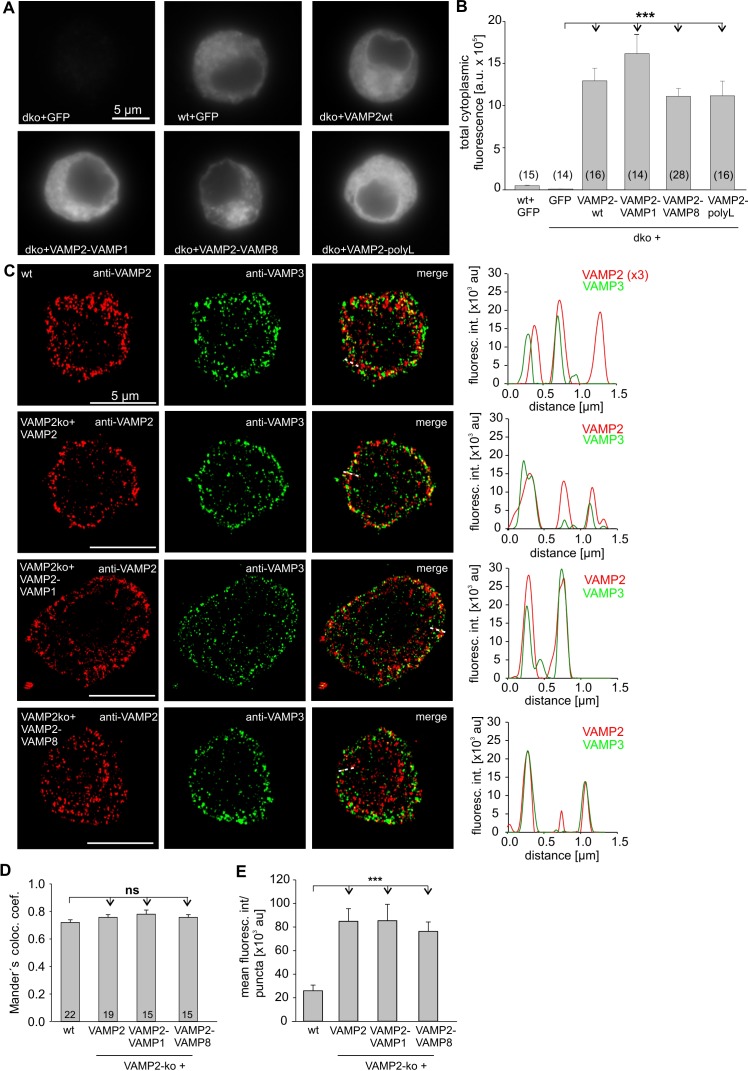
VAMP2-TMD mutants exhibit a similar expression and sorting pattern to granules as the wt protein.(A) Exemplary immunofluorescence images of wt and dko cells expressing either GFP, VAMP2 or its TMD mutant variants. Cells were immunolabelled with an affinity purified mouse monoclonal antibody against VAMP2 (clone 69.1, antigen epitope amino acid position 1–14). Note that signals in dko cells expressing VAMP2 or its mutant variants were stronger than in wt+GFP cells and were visualized after adjustment of the camera’s exposure time (e.g. wt+GFP,1.18s; dko+VAMP2, 0.076 s). (B) Mean total fluorescence intensity of wt+GFP, dko+GFP and dko cells expressing VAMP2 or the indicated mutants (determined 3.5 hr after transfection). (C) Representative structured illumination microscopy images (SIM) for VAMP2 (red) and the other v-SNARE protein VAMP3 (green) in wt and VAMP2-ko chromaffin cells expressing either VAMP2 or the indicated VAMP2-TMD mutant. VAMP2 fluorescence signals of wt cells were illuminated with a threefold higher laser power than in virus-transfected cells. The merged images and the corresponding line scans (dashed lines, right panels) display a clear colocalization between VAMP3 and VAMP2 or its mutant variants. (D) Mander’s weighted colocalization of VAMP2 or its TMD mutants to endogenous VAMP3 indicates a similar colocalization coefficient (71.9 ± 2%) for VAMP2 and the TMD mutant variants (VAMP2ko+: VAMP2, 73.8 ± 2%; VAMP2-VAMP1, 78 ± 3%; VAMP2-VAMP8, 76 ± 2%). Numbers of analyzed cells are indicated in the bar. (E) The fluorescence intensity of the discrete immunopositive puncta is similar for VAMP2 and the mutant protein and four times higher than for the littermate control (wt) cells. Images were thresholded to values 6 x SD of the background fluorescence to isolate discrete regions of interest for analysis. Data are represented as mean ± SEM. ***p<0.001, one-way analysis of variance between indicated groups followed by Tukey-Kramer post test (B, D and E).